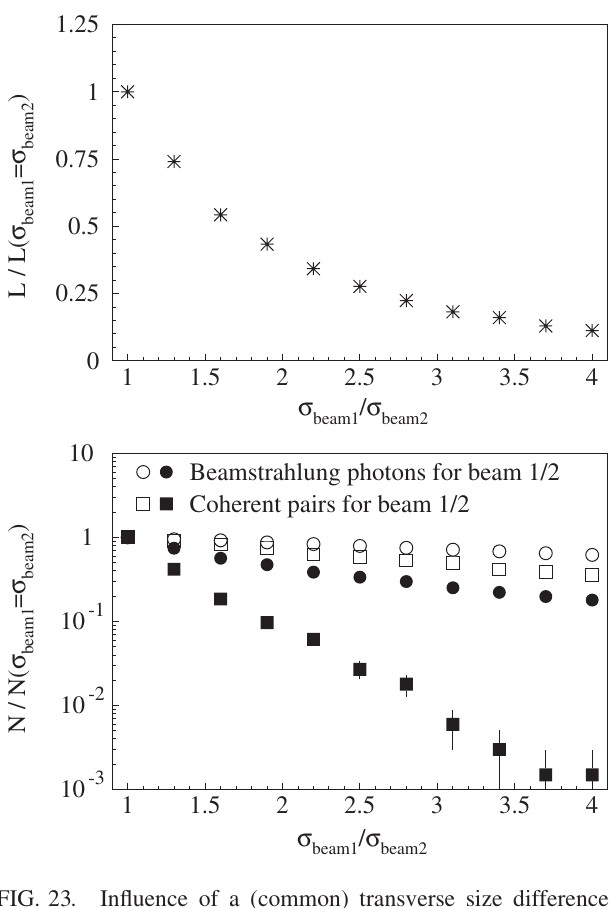
FIG. 23. Influence of a (common) transverse size difference between the incoming bunches on the luminosity (top) and on the amount of beamstrahlung photons and coherent pairs (bot-